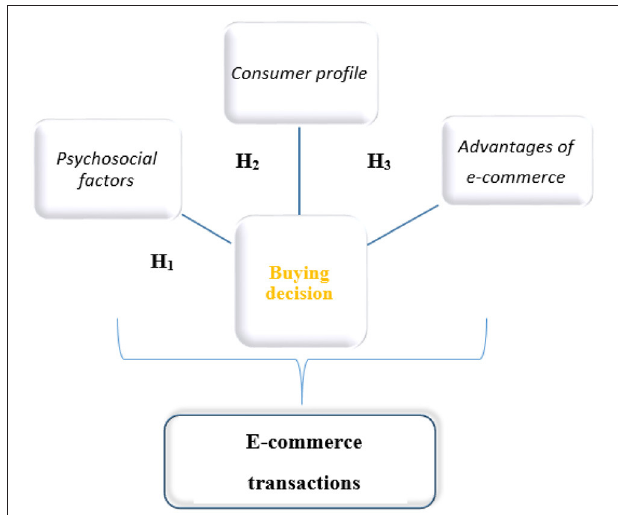
FIGURE 1 | Hypotheses development. Source: authors’ own